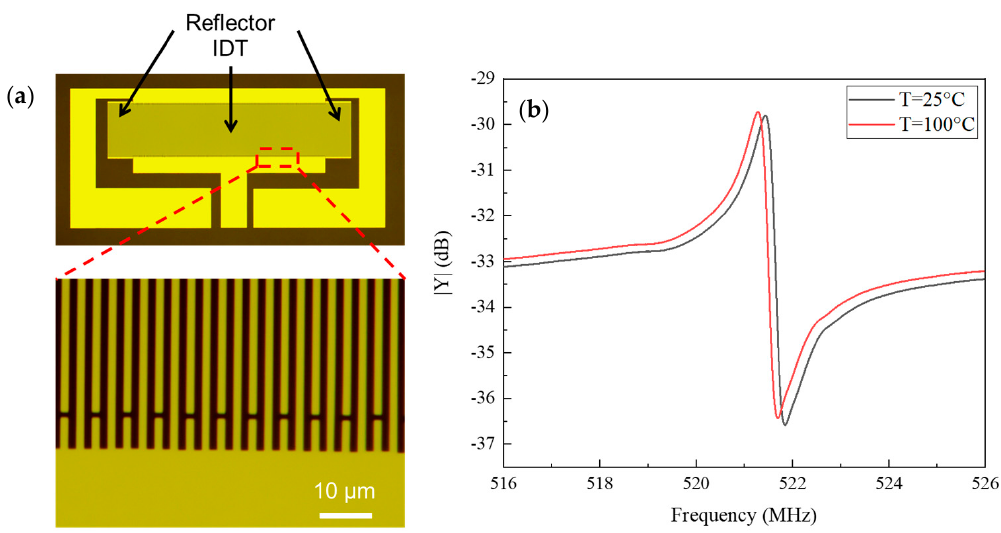
Figure 6. ( a ) Optical image and ( b ) the measured frequency response of a one-port SAW resonator based on quartz. Table 1. Detailed information on the above experimental sample.